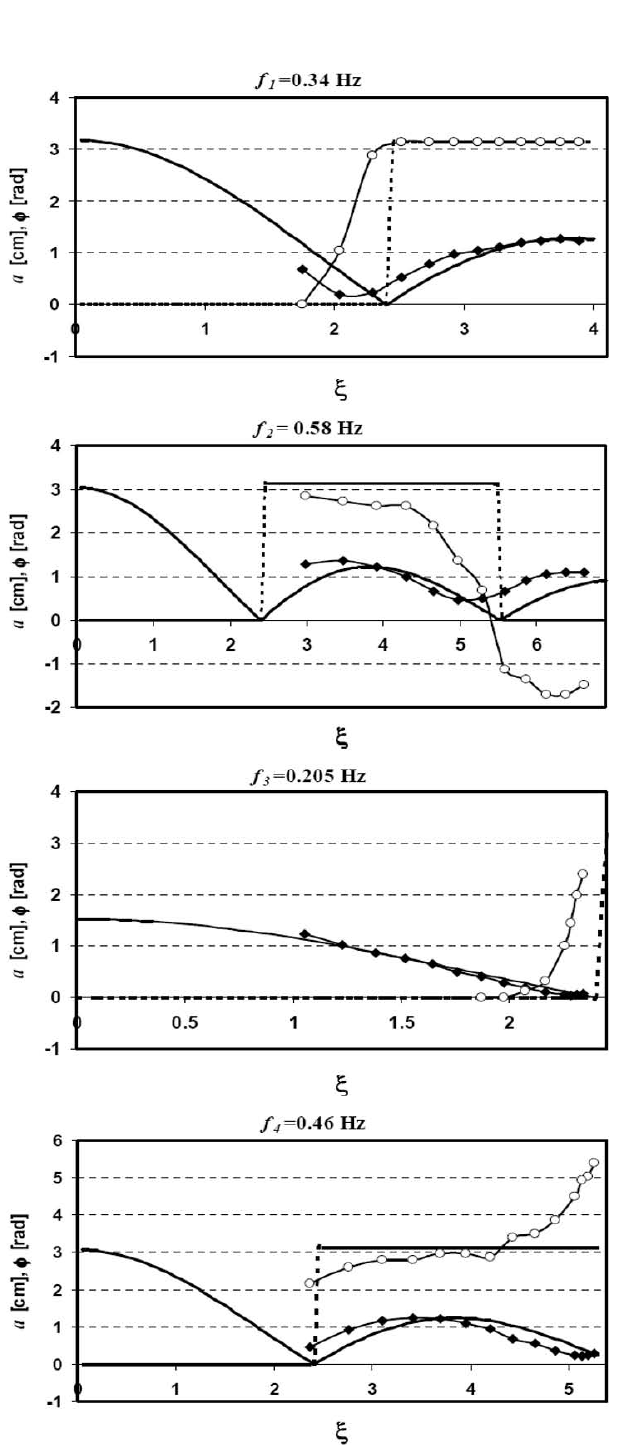
Fig. 5. Comparison of the experimental values of amplitude (di- amonds) and phase (circles) with theoretical values of amplitude (thick solid lines) and phase (thick dashed lines) obtained from the p Eq. (3), ξ = 4 ω 2 x/ g θ , θ = 0 . 168; ends of horizontal axes corre- spond the positions of the wave-maker